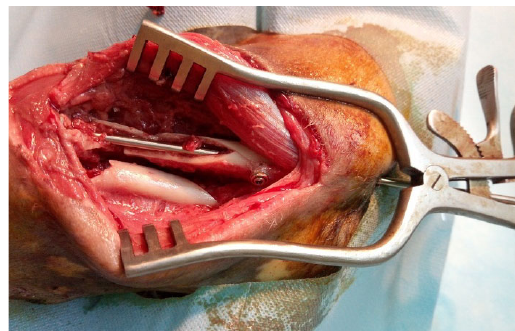
Fig. 4. Interlocking nail repaired proximal and distal fragments that were fixed with interlocking pin and a big third bone